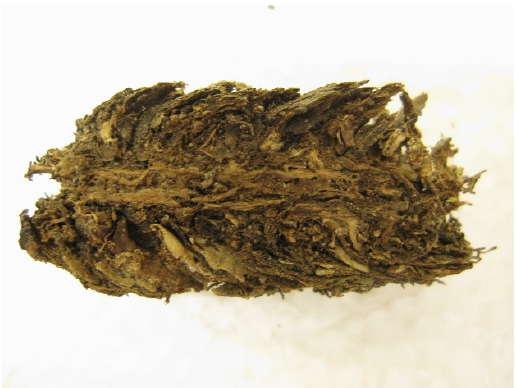
Figure 11. A spruce cone with intact shape was found just beneath a 28 years old nylon strip. By chance it was cut longitudinally during sampling. The underside of the cone was situated about 1 cm above the spodic horizon. From [16].